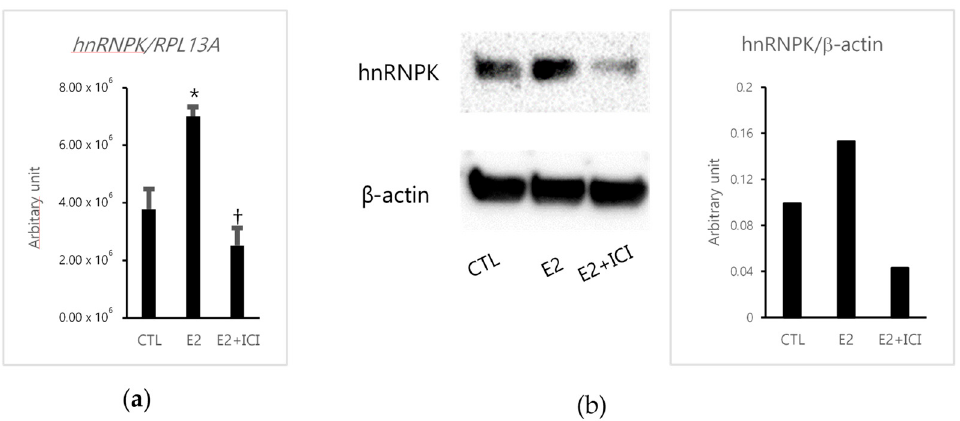
Figure 1. The effects of estradiol (E2) in MCF-7 cells. ( a ) Real-time PCR analysis of heterogeneous nuclear ribonucleoprotein K (hnRNPK). MCF-7 cells were treated with E2 alone or E2 combined with ICI 182,780 (E2+ICI) for 48 h and before RT–PCR. * p = 0.0003 versus control (CTL) for E2; † p = 0.0359 versus CTL for E2+ICI. ( b ) Western blotting assay of hnRNPK (65 kDa). MCF-7 cells were treated with E2 alone or E2+ICI for 72 h. β -actin (40 kDa) was used as the loading control. The full-length Western blot images are summarized in Supplementary Figure S1a.